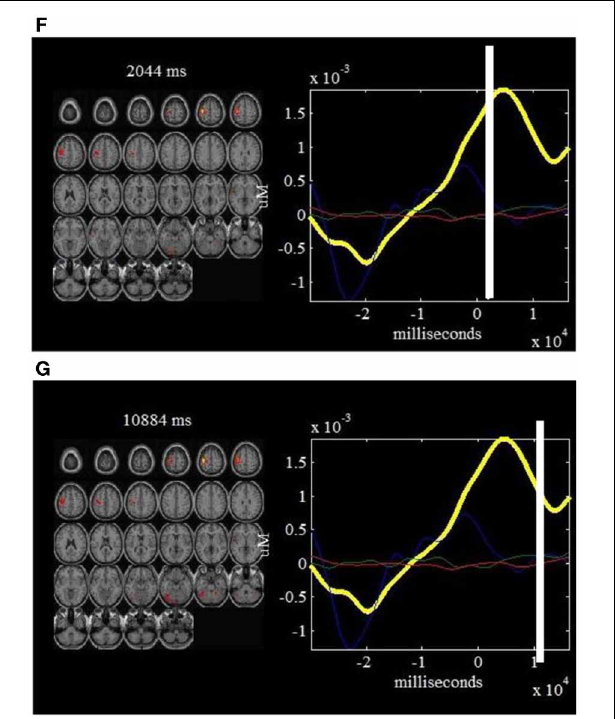
FIGURE 4 | (cid:2) HbO 2 components and fMRI “snapshots”: on the left of each window is shown a linear combination of the fMRI maps that are well-correlated with finger tapping tasks (composite ICs 2, 4, and 5), weighted by the (cid:2) HbO 2 part of the components at a specific point in time. On the right of each window is shown the estimated (cid:2) HbO 2 components that are correlated with right finger tapping tasks. The time courses for IC2 (in blue), IC4 (in green) and IC5 (in red) are also plotted on the right of each window. Such a display provides a dynamic way to visualize the brain activity at different time points: − 20943ms (A) , − 11217 ms (B) , − 8210ms (C) , − 5559ms (D) , − 2729ms (E) , 2044ms (F) and 10884ms (G)